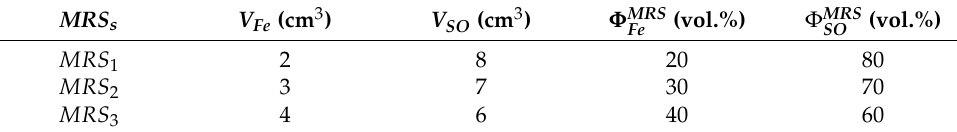
Table 1. Volumes ( V ) and volumetric fractions ( Φ ) used to obtain MRS samples.